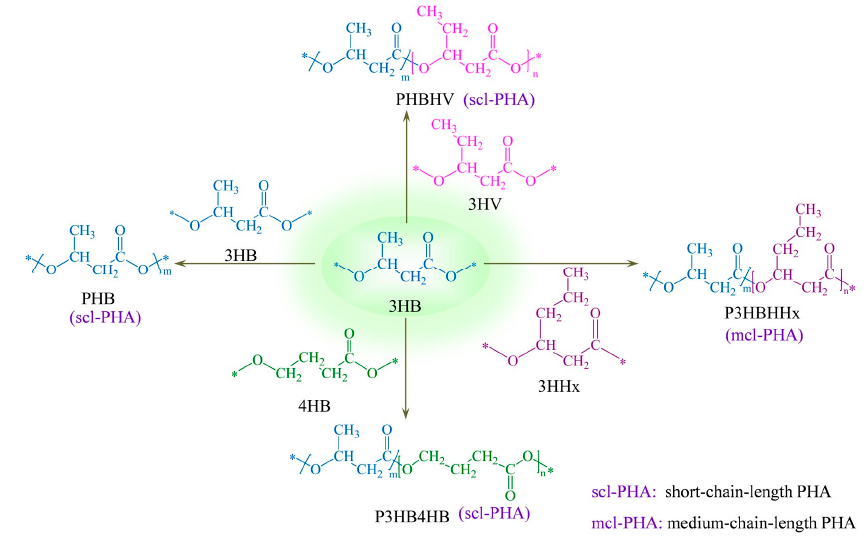
Figure 2. General structure of various copolymers of PHA.